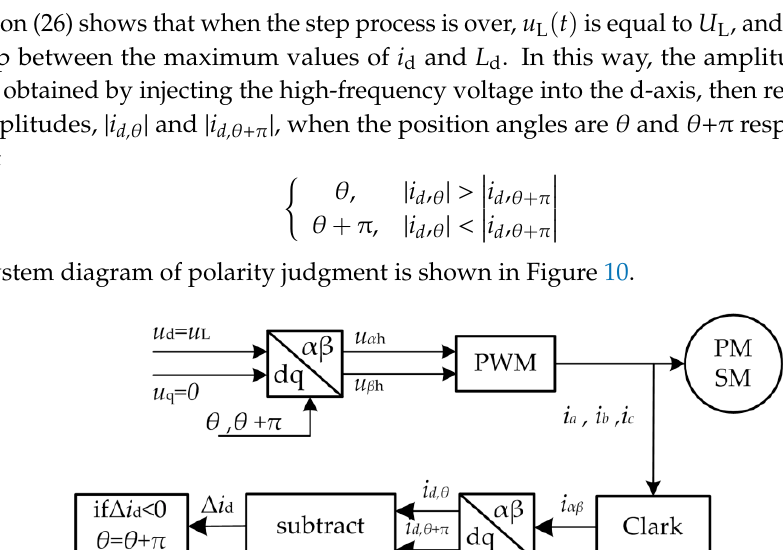
Table 1. The simulation parameters of the PMSM.